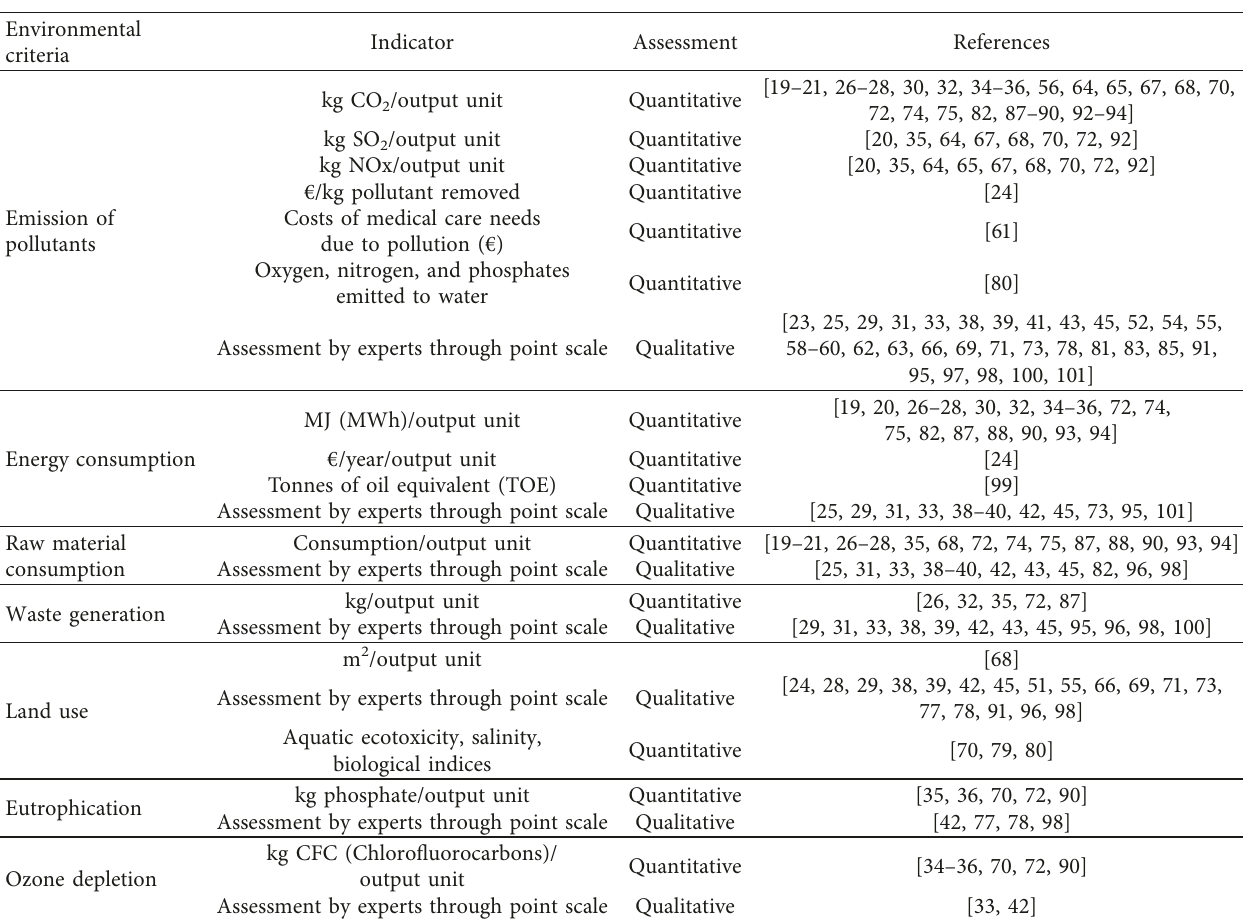
Table 2: Main environmental criteria and